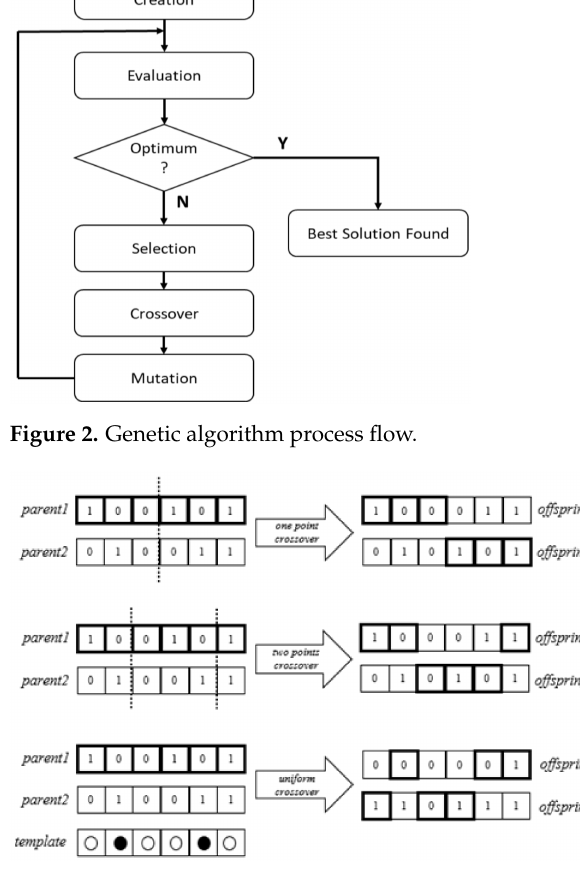
Figure 3. Illustration of some crossover-type